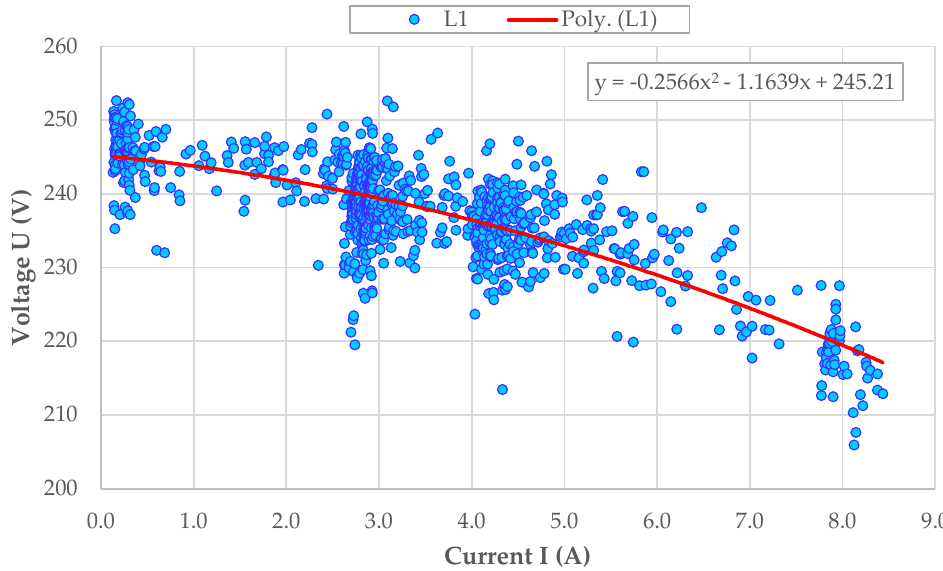
Figure 10. Phase L1 voltage–current curve based on measurements with polynomial function describing the voltage drop dependency from the capacity of the load in Object 1. Table 1. One-phase short-circuit impedance estimation for Object 1.